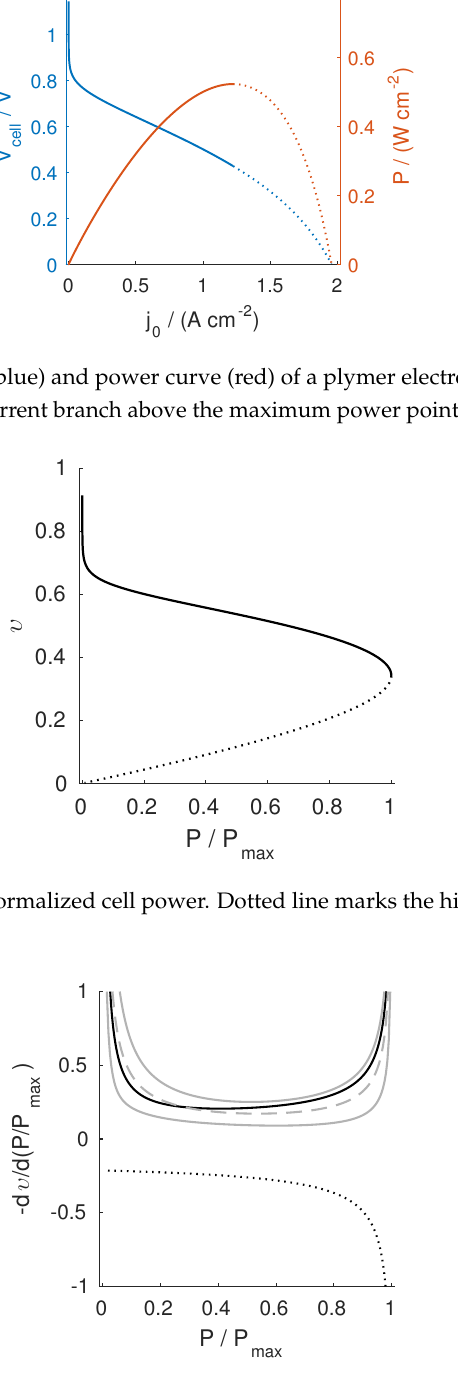
Figure 3. Efficiency gain that is obtained from lowering the power as function of operating power. The dotted line marks the branch above the maximum power point. Analysis of 41 experimental polarization curves [23] is marked in grey: the dashed line marks the average and the grey solid line mark the 99% confidence